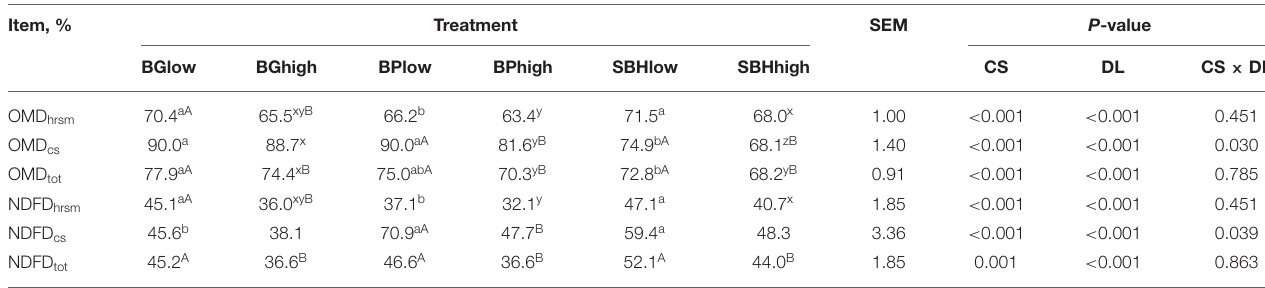
TABLE 2 | In vitro organic matter degradability (OMD) and neutral detergent degradability (NDFD) of different carbohydrate sources incubated at high and low dilution rate for 48h.